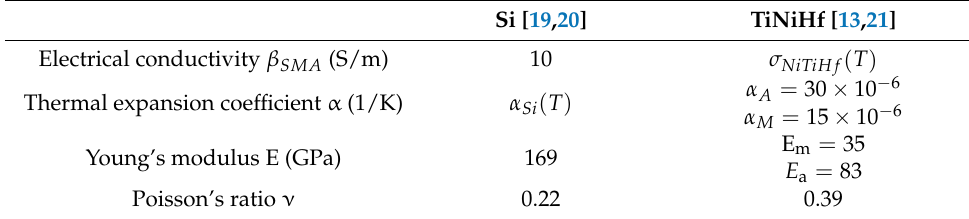
Table 1. Material properties for coupled electro-thermo-mechanical simulation of temperature profiles for TiNiHf/Si bimorph microactuators. The Poisson ratio of Si is included in the COMSOL material library. A polynomial function approximates the thermal expansion coefficient of Si [18]: α Si ( T ) =